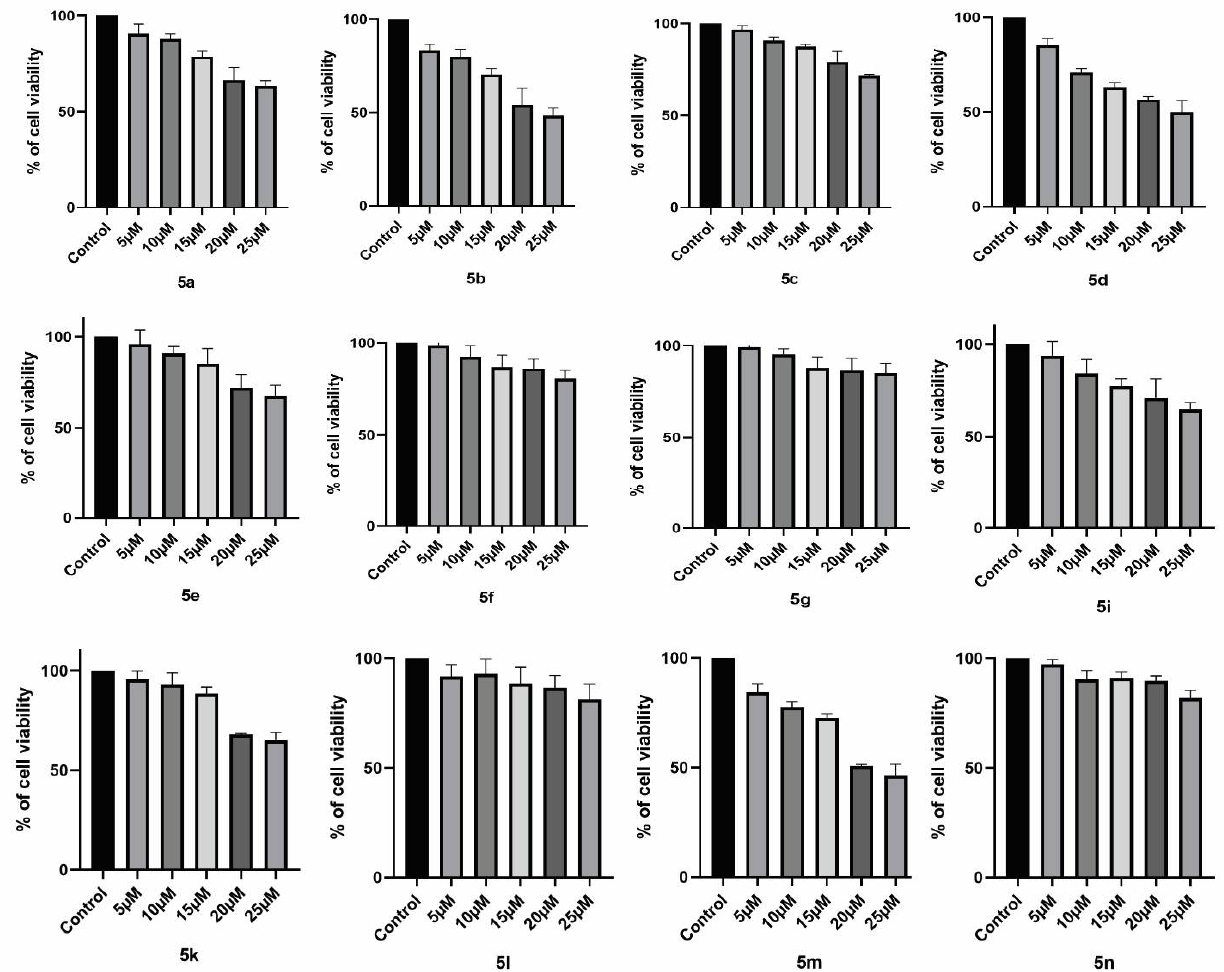
Figure 6. % Cell viability data for the screened compounds have been represented. Table 7. IC 50 values and % cell death for all the newly synthesized compounds.